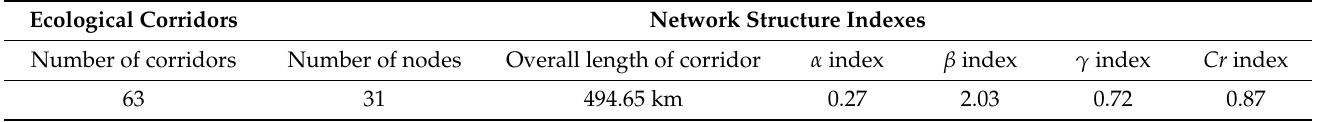
Table 5. Evaluation of the ecological corridor network structure